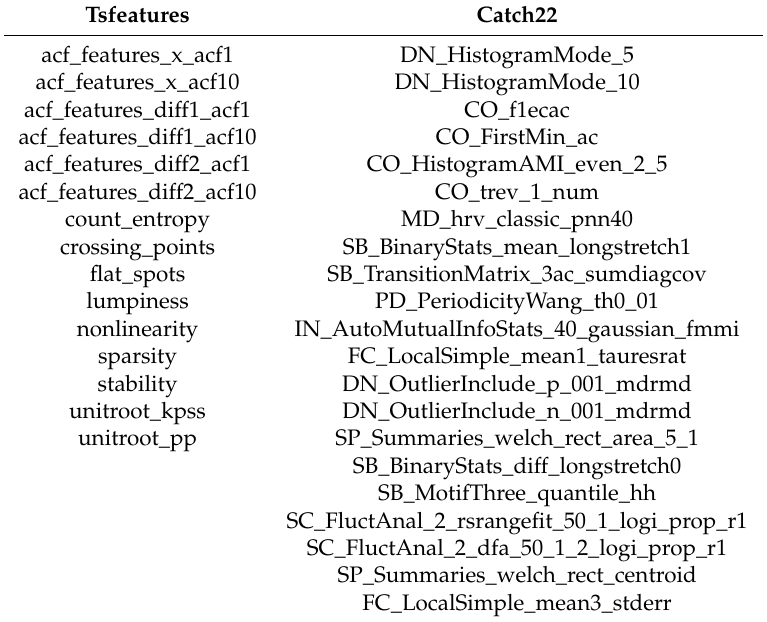
Table 1. Time series characteristics used for feature generation with a rolling